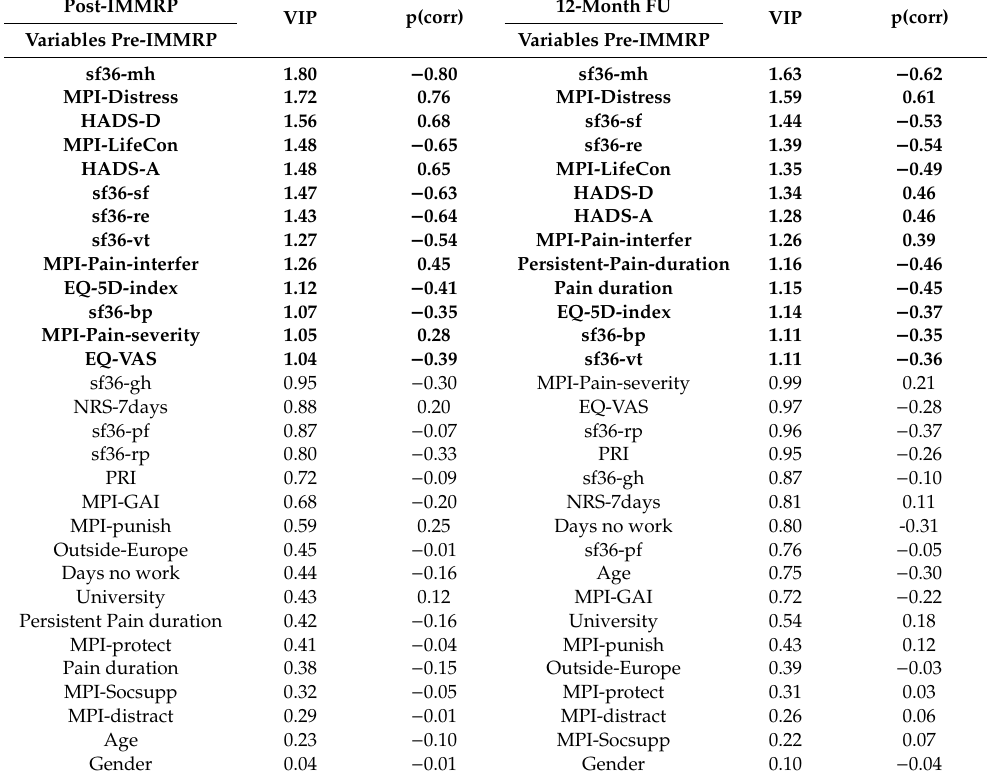
Table 10. Orthogonal Partial Least Square Regressions (OPLS) regressions of MIS post-IMMRP (left part) and at 12-month FU (right part) using the variables pre-IMMRP as regressors. Variables in bold type are significant